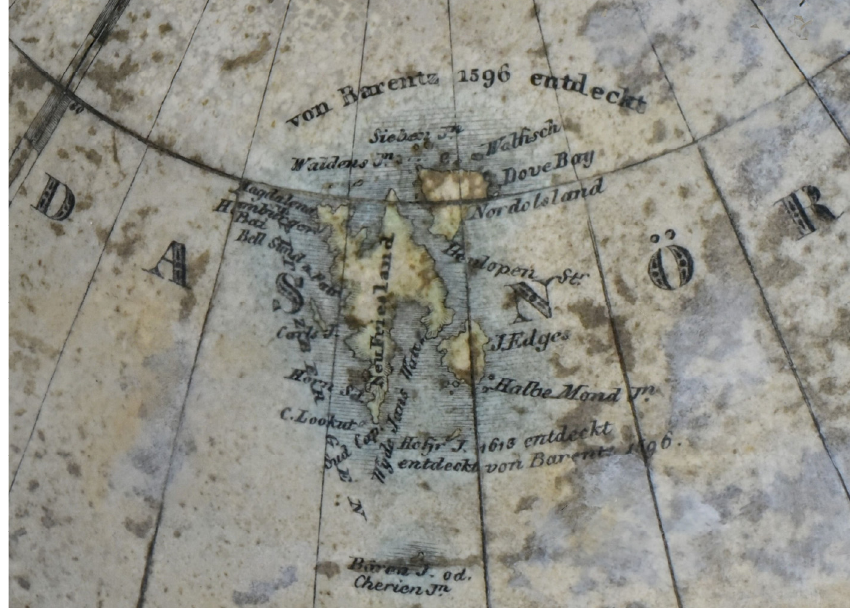
Figure 10. Barentze’ discovery—von Barentz 1596 entdeckt. Source: Map Collection of the Faculty of Science, Charles University.